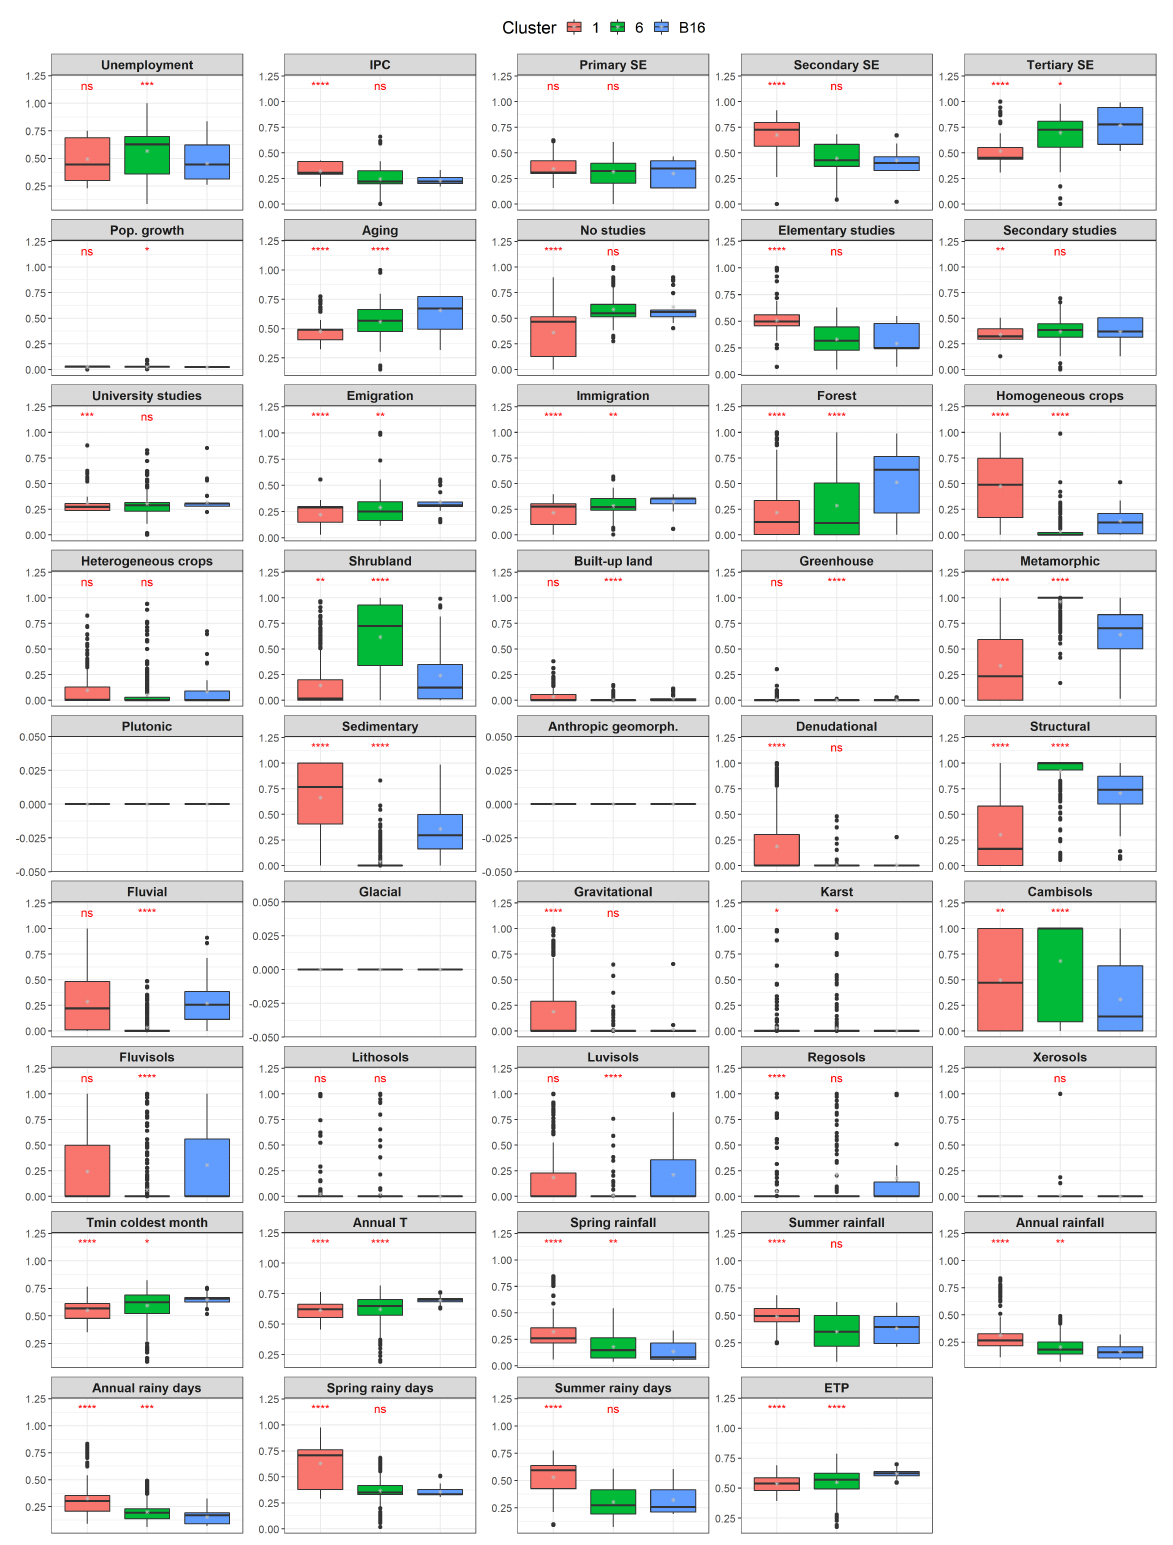
Figure A2. Comparison of the socio-ecological variables between Sectors 1 and 6 and the boundary between them (B16). Statistical significance is shown as: ns: p -value > 0.05; *: p -value ≤ 0.05; **: p -value ≤ 0.01; ***: p -value ≤ 0.001; ****: p -value ≤